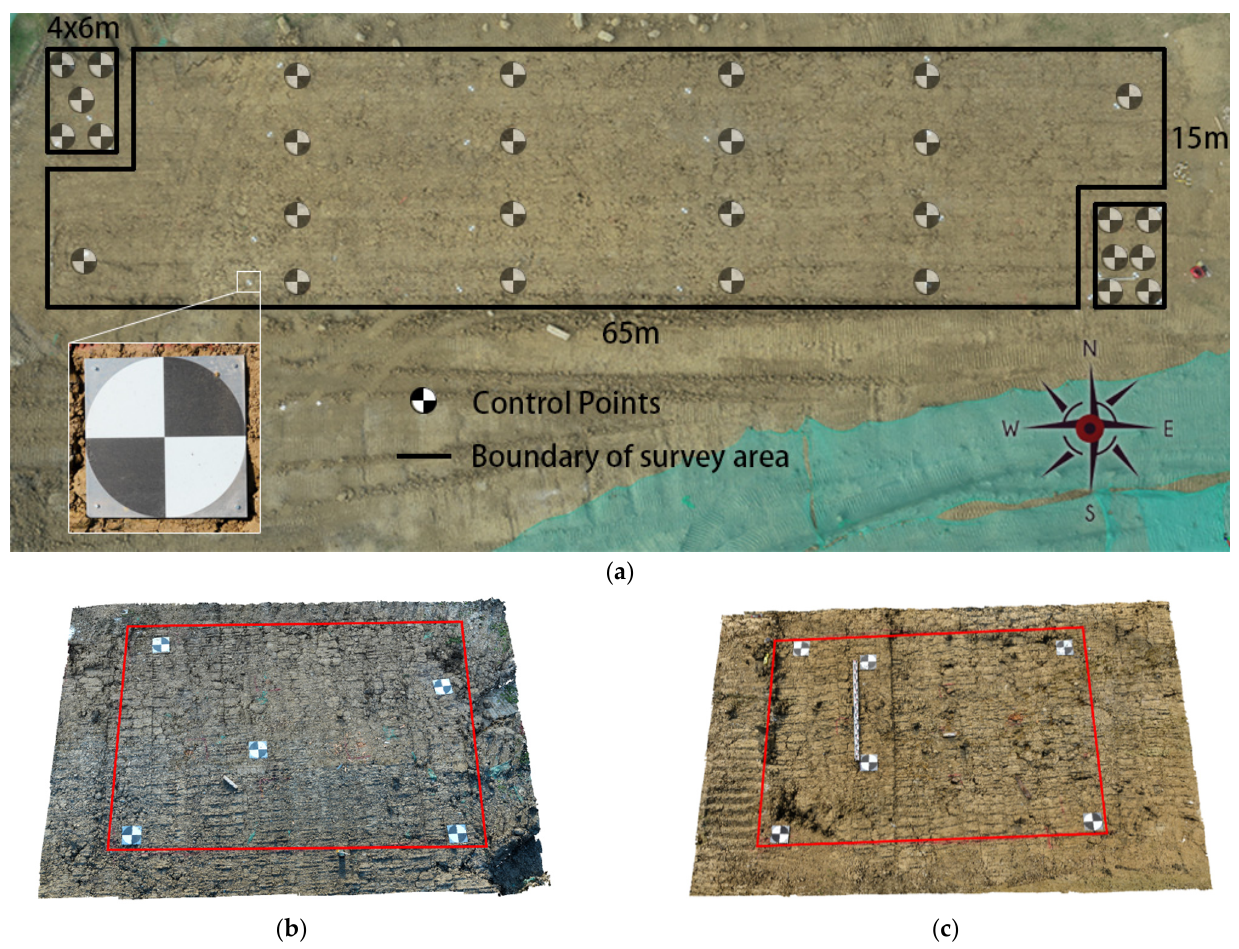
Figure 7. Overview of the experimental site and two representative areas on the corners. ( a ) Over- view of the whole experimental site; ( b ) northwest corner (NWC); ( c ) southeast corner (SEC).